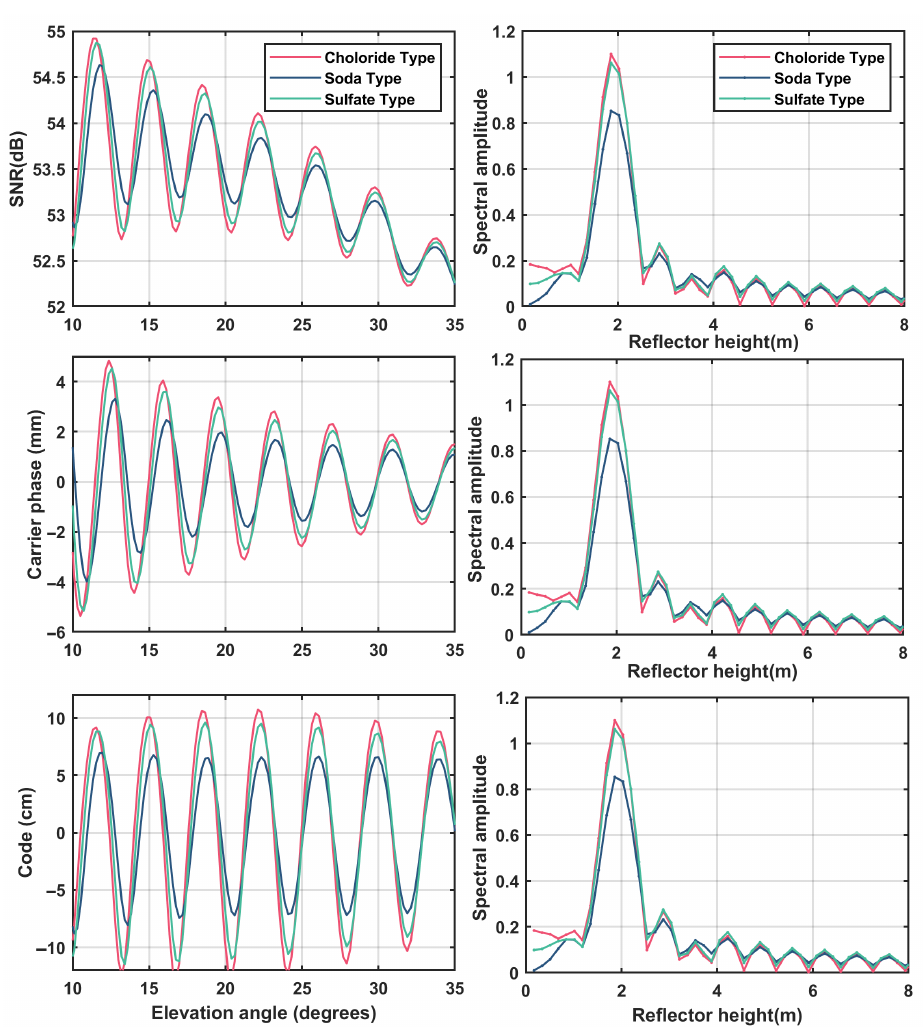
Figure 8. The multipath observation and effective reflectometer height changes for three different saline soil